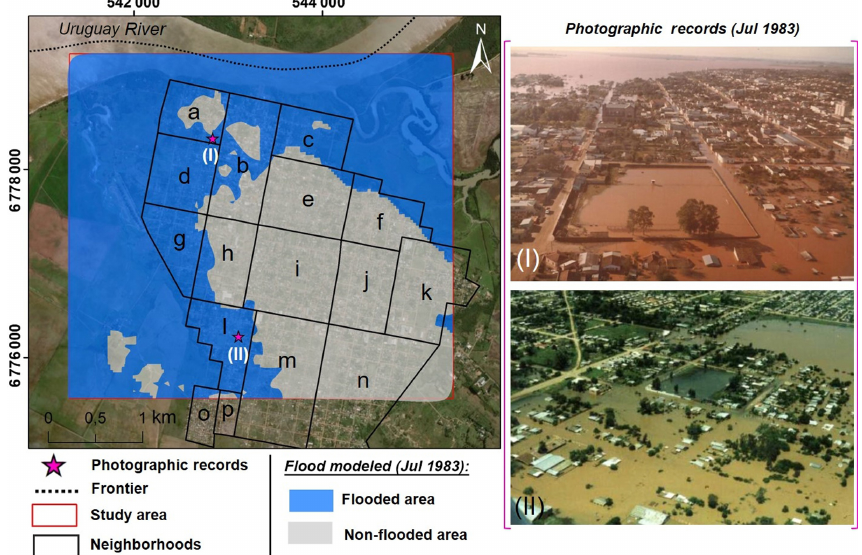
Figure 9. The worst historical flooding of the Uruguay River basin (July 1983) has been used here as a base for a simulated flood event in Itaqui. Neighborhoods: (a) Cerrinho Dois Umbus; (b) Centro; (c) Ponte Seca; (d) Várzea; (e) Cidade Alta; (f) Cohab; (g) Enio Sayago; (h) Estacao; (i) Capelinha; (j) Dr. Ayub; (k) Jose da Luz; (l) Vinte e Quatro de Maio; (m) Chacara; (n) Cafifas; (o) Vila Nova; and (p) Uniao. Photographic records: (I) the courtyard of the prison of Itaqui (Flores and Flores, 1983; Saueressig e Robaina, 2015); (II) the neighborhood of Vinte e Quatro de Maio (Boeira, 1983; Saueressig,